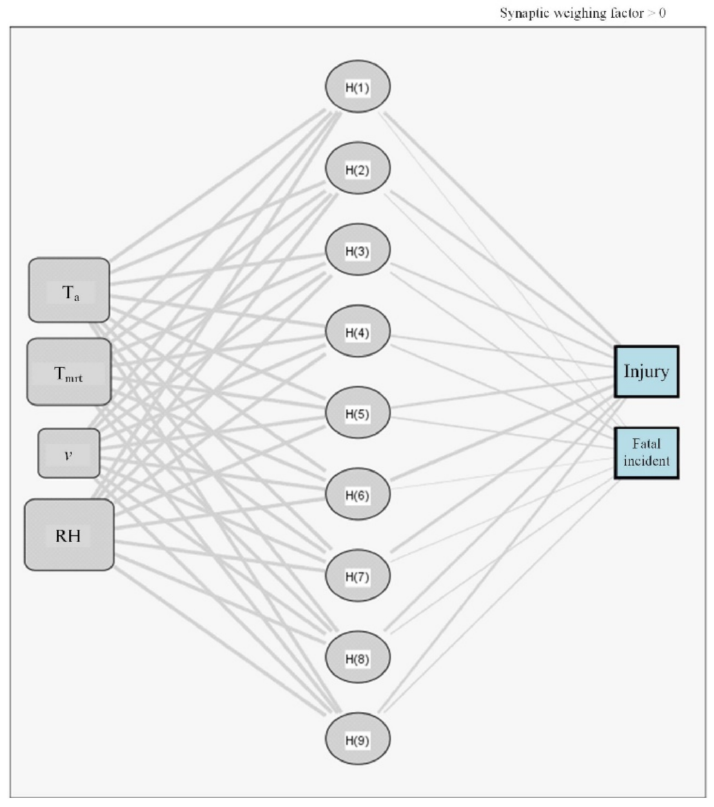
Figure 9. Graph of the neural network of weighting